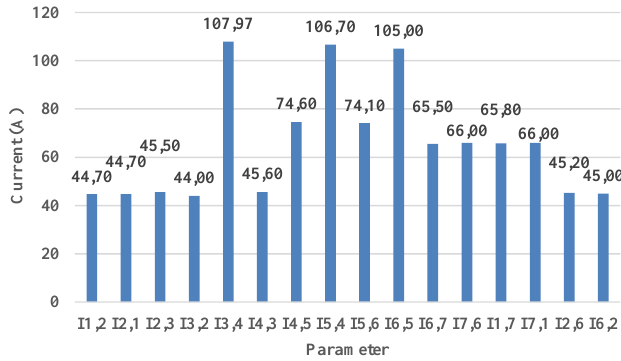
Figure 11. The DEsimulation results for seven-bus system.